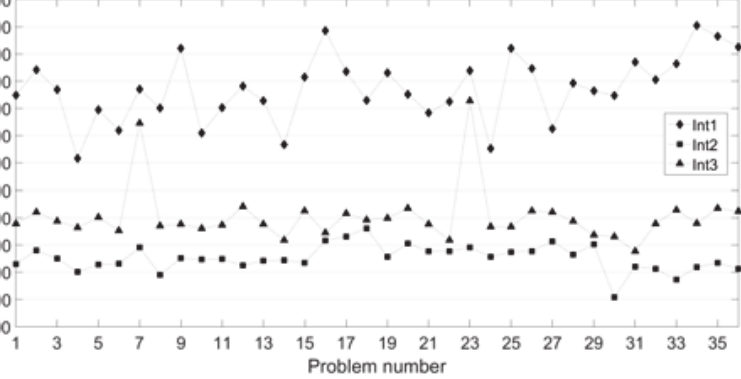
Figure 2. Graphical representation of Int 1 , Int 2 and Int 3